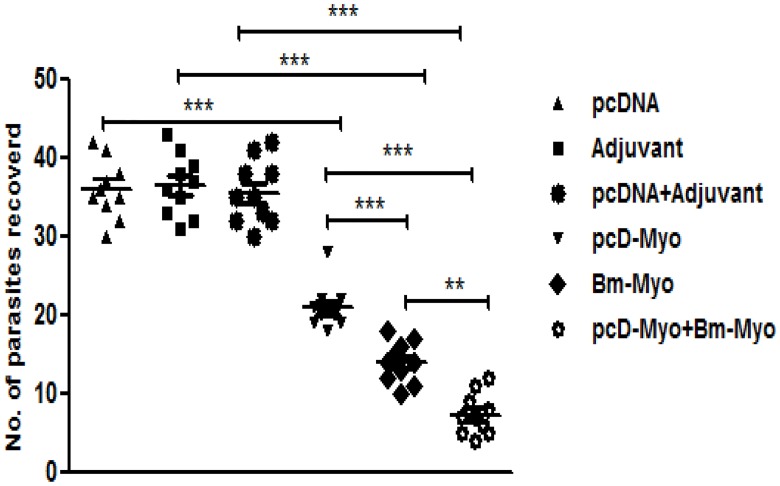
Mice were challenged with 50 L3 of B. malayi by intraperitoneal route and euthanized on day 10 post L3 challenge to recover developing parasites.The distribution graph was drawn by Prism 5.0 and horizontal bars represent arithmetic mean values derived from two separate experiments (n = 5) in each experiment. Significant difference in parasite recovery was obtained between pcD-Myo+Bm-Myo immunized group as compared to Bm-Myo (* P<0.01) and pcD-Myo (*** P<0.001). Similarly Bm-myo showed significant reduction in parasite recovery as compared to pcD-Myo (** P<0.01) group of mice.